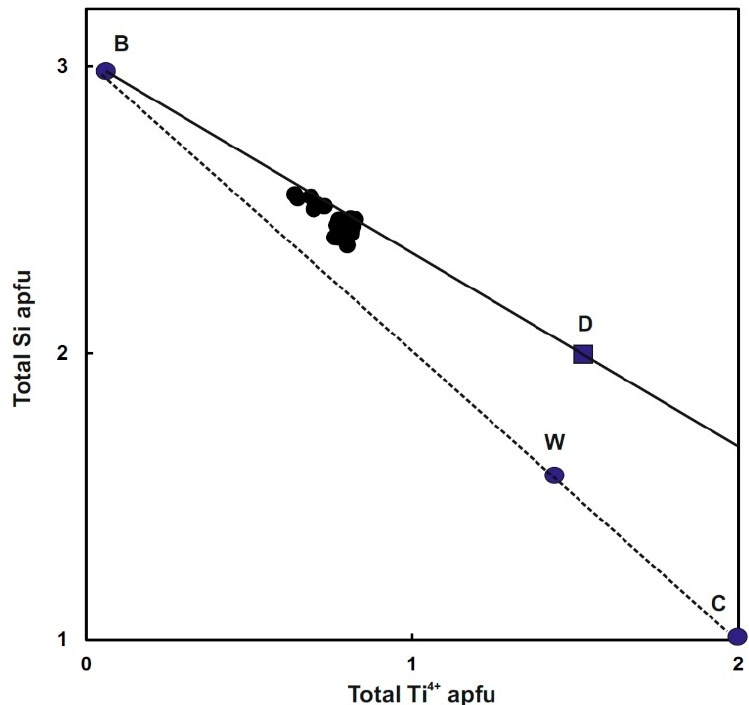
Figure 7. Variation of Si content at the Z site with Ti 4+ content at the Y site [47]. Point W represents a synthetic sample [57], and point C represents the position where Ti = 2 and Si = 1 apfu. Point D represents the composition midway between schorlomite and morimotoite. In general, the studied garnet is enriched in LREE (average 731 ppm) and is rela- tively depleted in HREE (average 186 ppm). The LREE/HREE ratio varies from 3.21 to 4.89, whereas La N /Yb N varies from 1.11 to 2.11. By and large, LREE-enriched and HREE- depleted REE pattern (see Figure 6a) is displayed by andradite–grossular garnets found in skarn deposits [6,8,58–61]. On the other hand, the HREE-enriched and LREE-depleted REE pattern is mainly displayed by Al-rich garnets (pyrope, almandine, spessartine, and grossular) from metamorphic and magmatic systems [5,62–71]. The observed LREE en- riched pattern of the studied garnets (Figure 6a) is similar to the REE pattern of skarn deposit, which attests to the active role of metasomatic processes involving hydrothermal fluids. Our observation of LREE enrichment in garnet is consistent with the earlier stud- ies [56,72]; it is suggested that hydrothermal activity is the primary factor accountable for the significant LREE mineralization in the Ambadungar